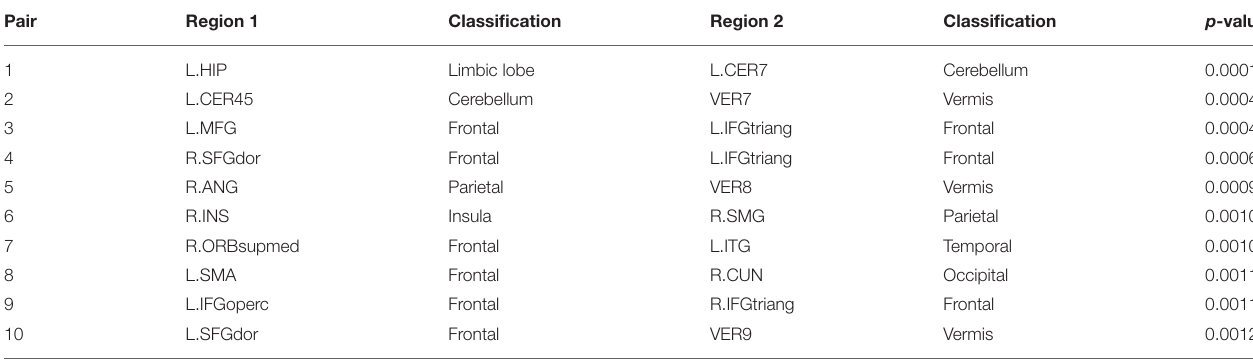
TABLE 2 | The first 10 most significant pairs for sparse correlation based on low-rank matrices. Pair